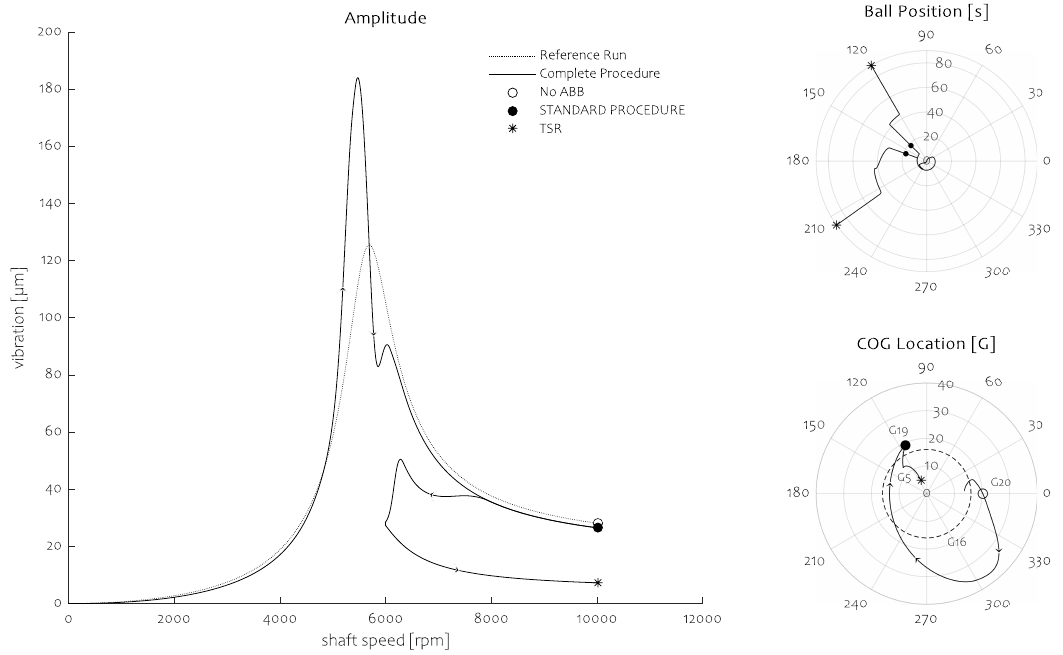
Figure 4. A single run-up following the aforementioned speed profile illustrating the temporal speed reduction (TSR)